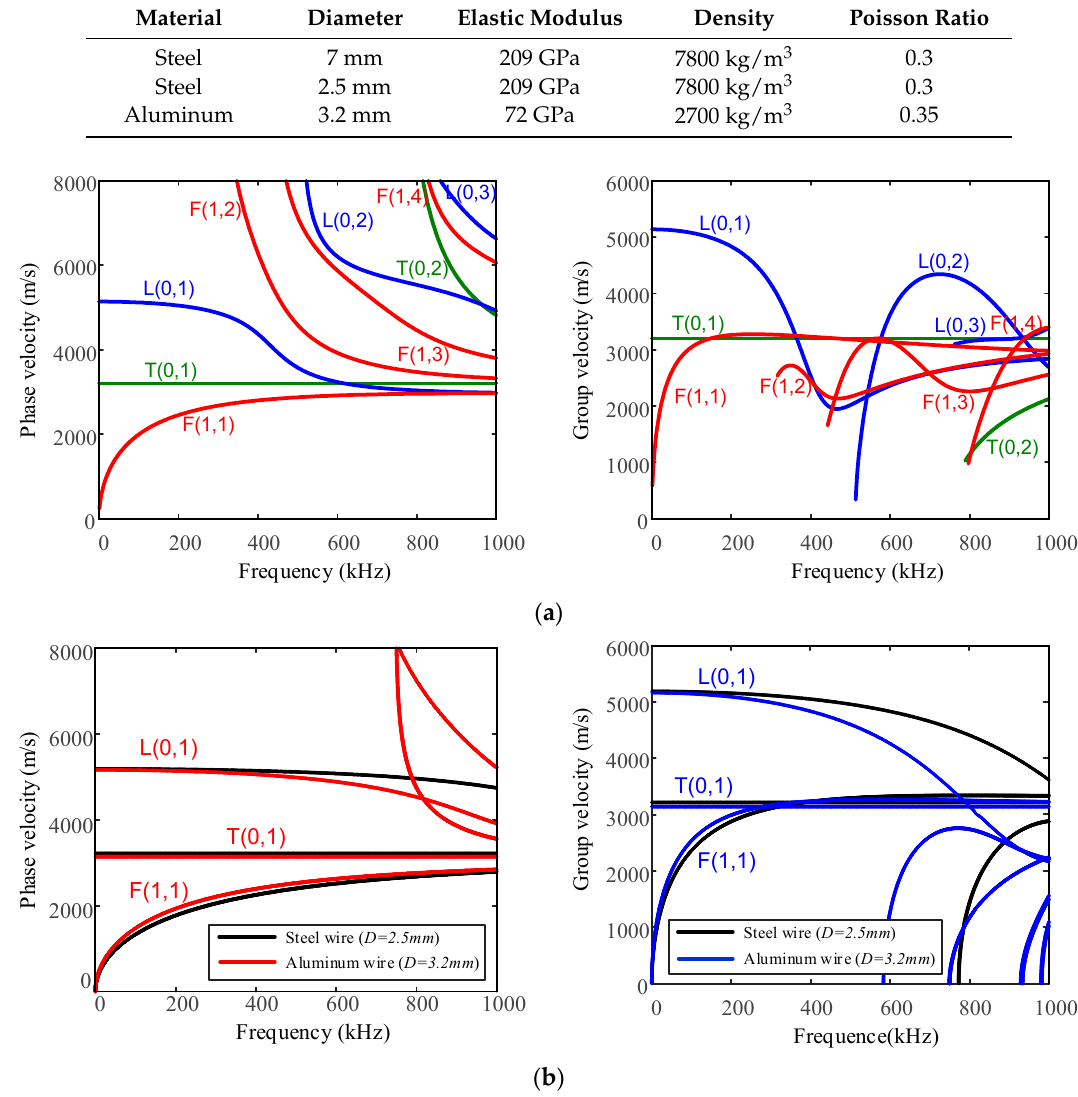
Figure 1. Phase and group velocity dispersion curves for ( a ) a single 7-mm-diameter steel wire and ( b ) a single steel and aluminum wire with a diameter of 2.5 mm and 3.2 mm, respectively.